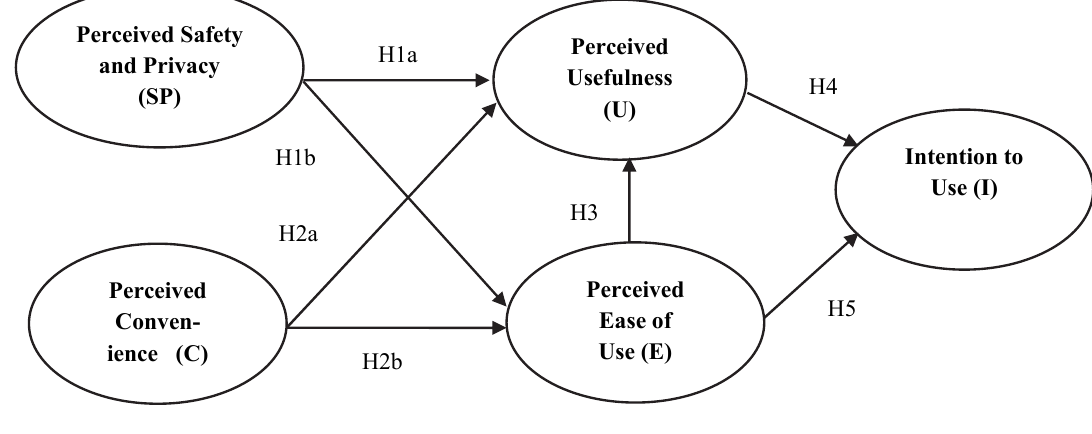
Fig. 2. The proposed conceptual